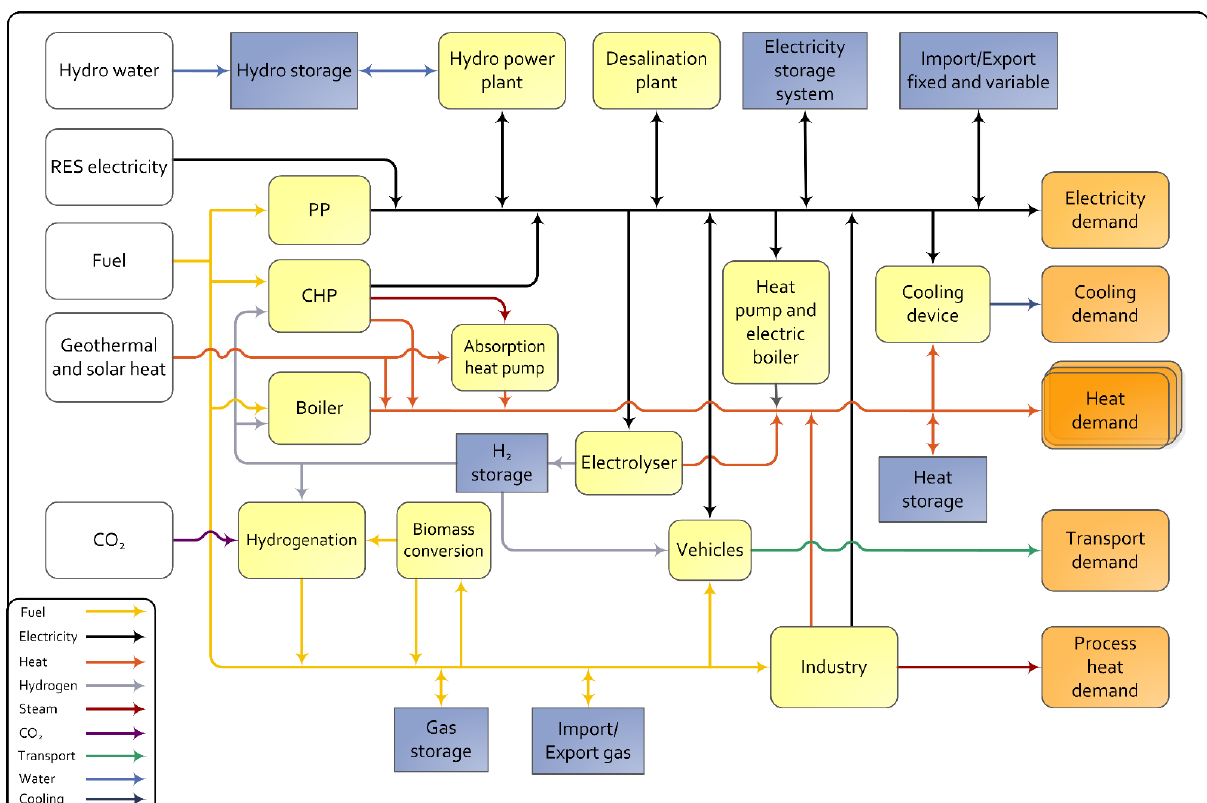
Figure 3. Schematic diagram of EnergyPLAN [55].